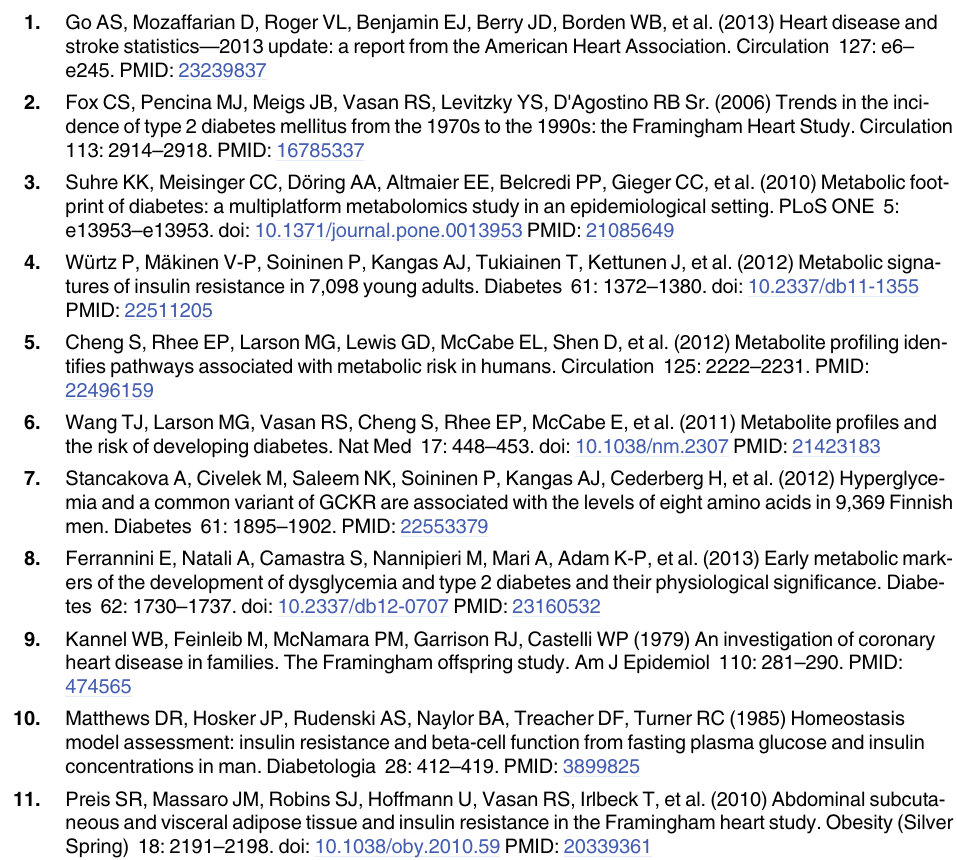
S1 Table. Full results of metabolite associations with cardiometabolic traits.